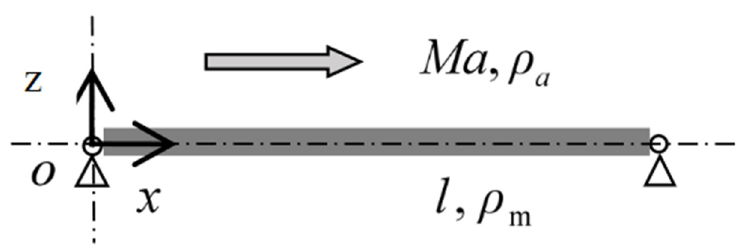
Figure 1. A two-dimensional flat panel in supersonic airflow.